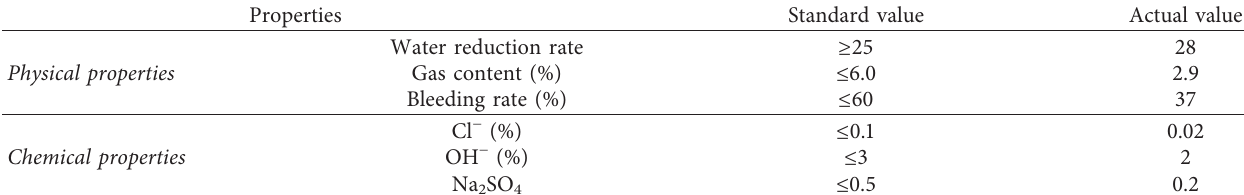
Table 5: Physical and chemical properties of superplasticizer.